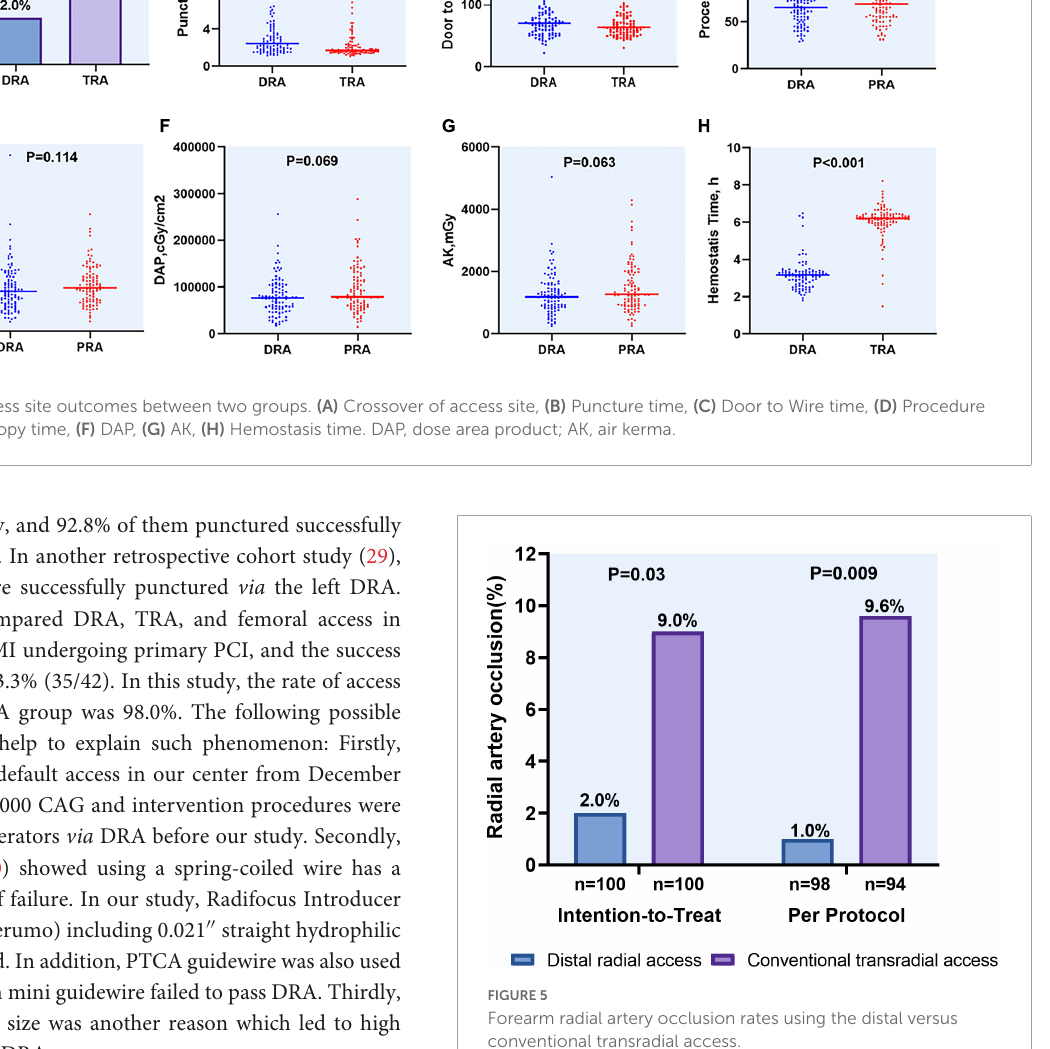
higher in the DRA group than in the TRA group [2.4